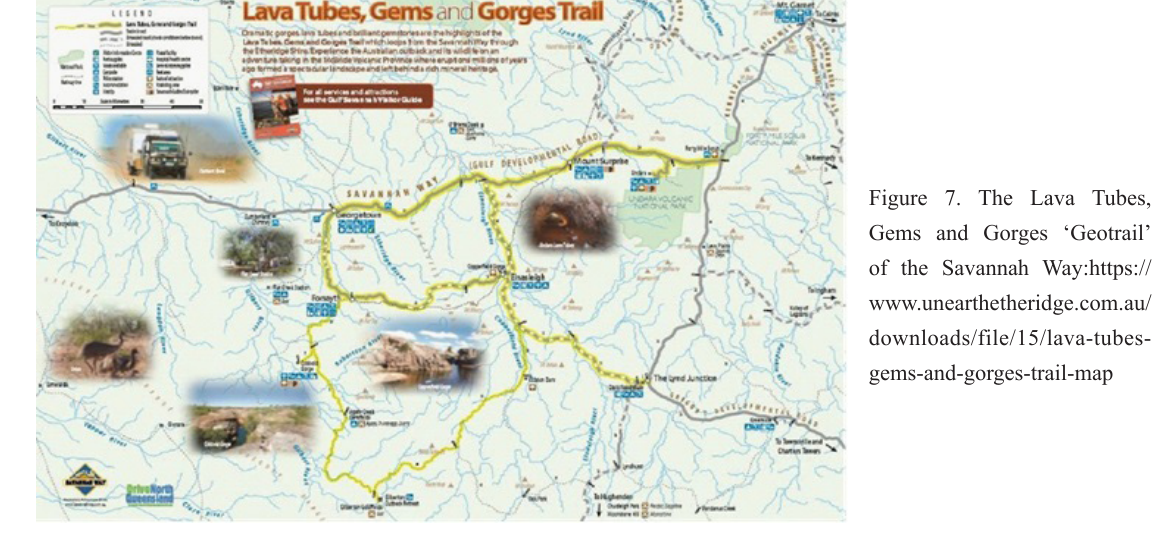
Figure 7. The Lava